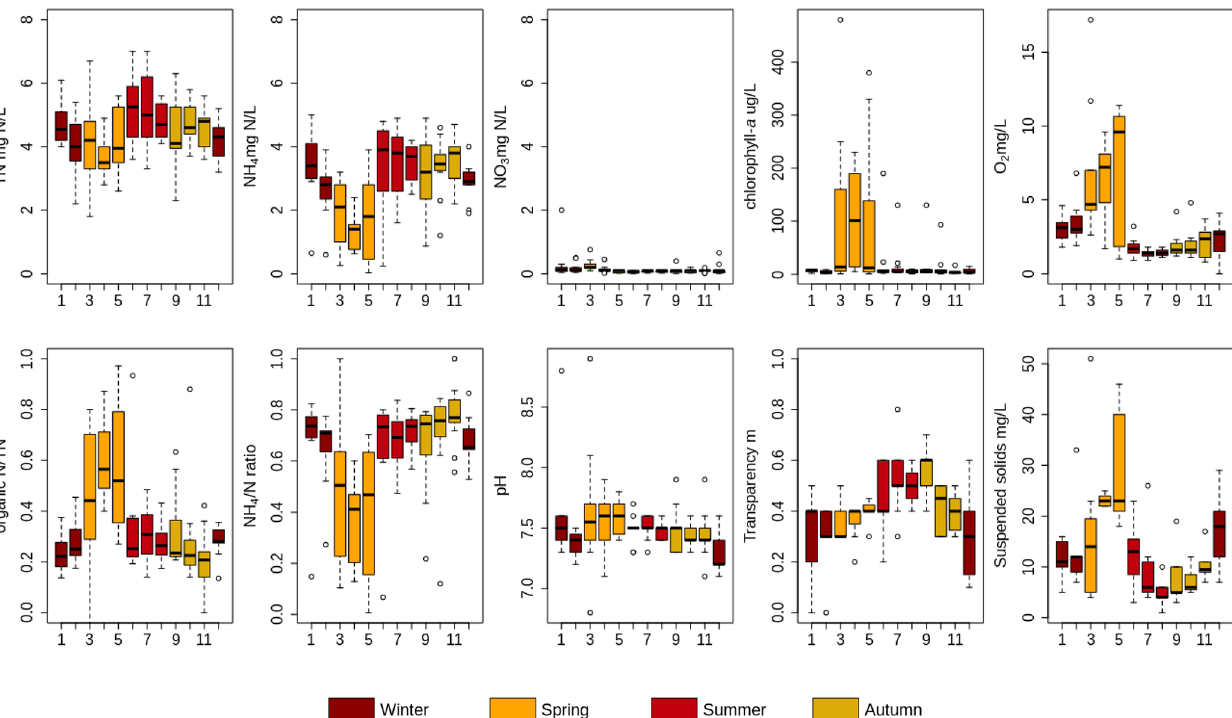
Figure 6. Monthly measurements of TN, NH 4 -N, NO 3 -N, chlorophyll a , O 2 organic N / TN and NH 4 -N / TN (NH 4 / N) mass ratio, pH, water transparency, and suspended solids in Geuzenveld from 2007 to 2018. X axis is month. See Tables S15–S19 for the correlation tests performed on the